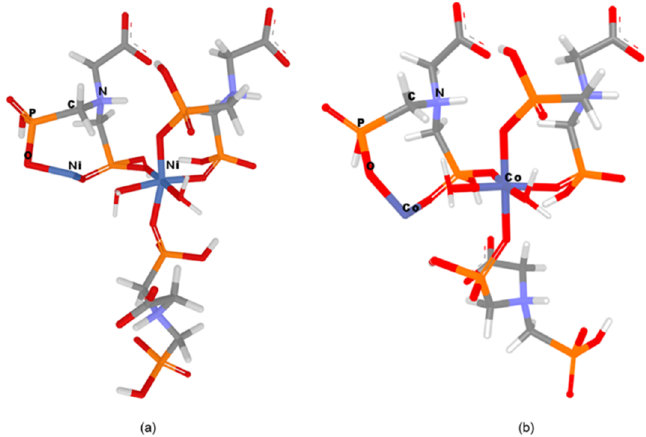
Figure 7. Models representation ( a ) Ni–Gly; ( b ) Co–Gly.